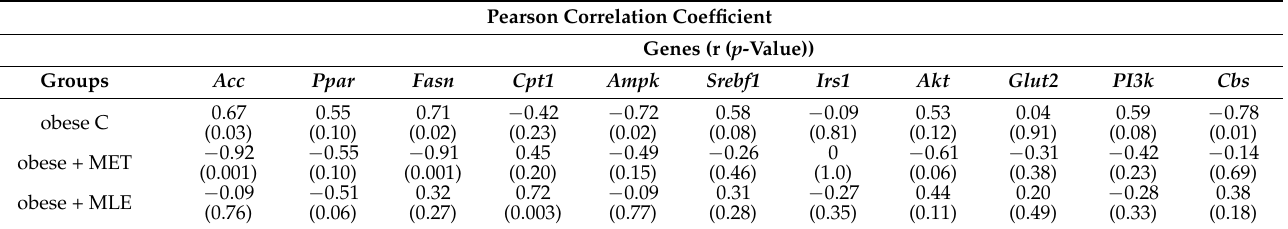
Table 1. Pearson’s correlation analysis of hepatic methylenetetrahydrofolate reductase (MTHFR) with genes involved in insulin signaling, beta-oxidation and DNA methylation. Pearson Correlation Coefficient Genes (r ( p